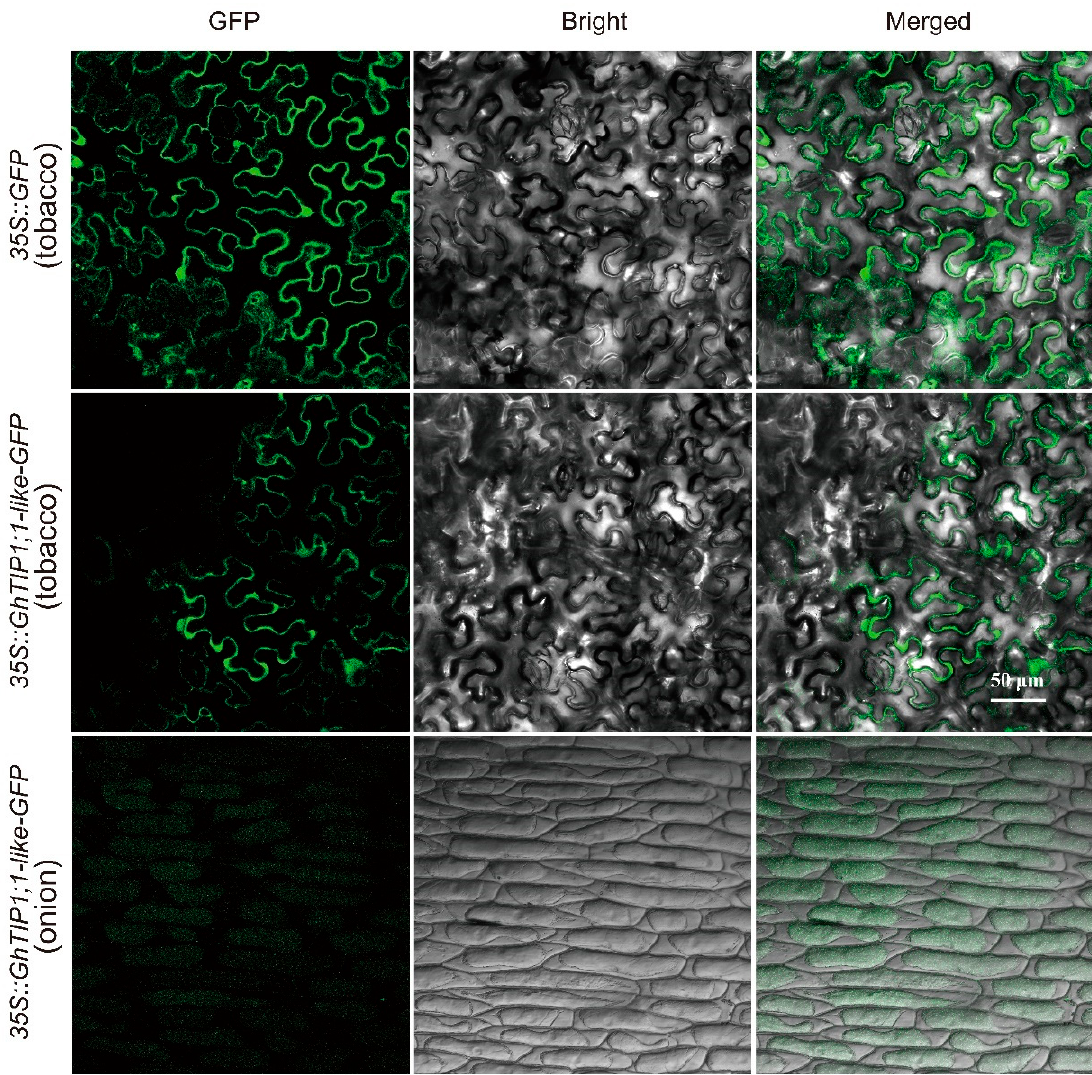
Figure 2. Subcellular localization of GhTIP1;1-like in Nicotiana benthamiana leaf epidermal cells and onion epidermal cells. Epidermal cells of tobacco leaves and onion epidermal cells were infected with recombinant vector 35S::GhTIP1;1-like-GFP and visualized by fluorescence microscopy. Onion epidermal cells were subjected to plasmolysis assay with 30% sucrose before taking pictures.